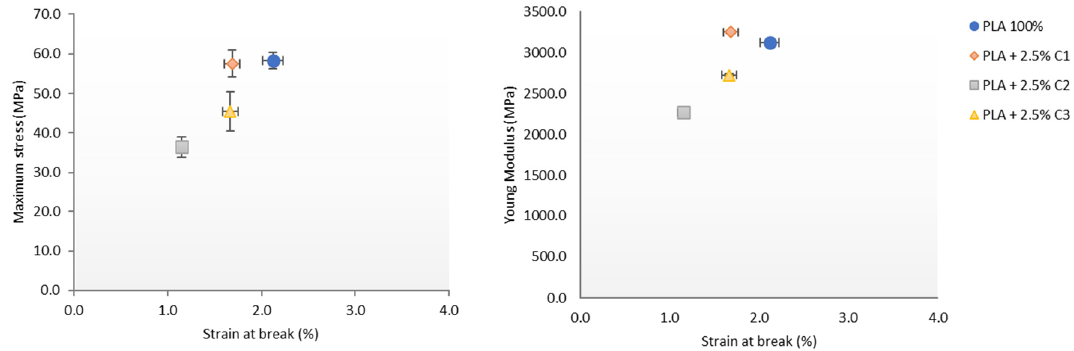
Figure 8. ( Left ) Maximum stress vs. strain at break and ( Right ) Young’s Modulus vs. strain at break, for PLA with 2.5% concentrations of the different compatibilizers.